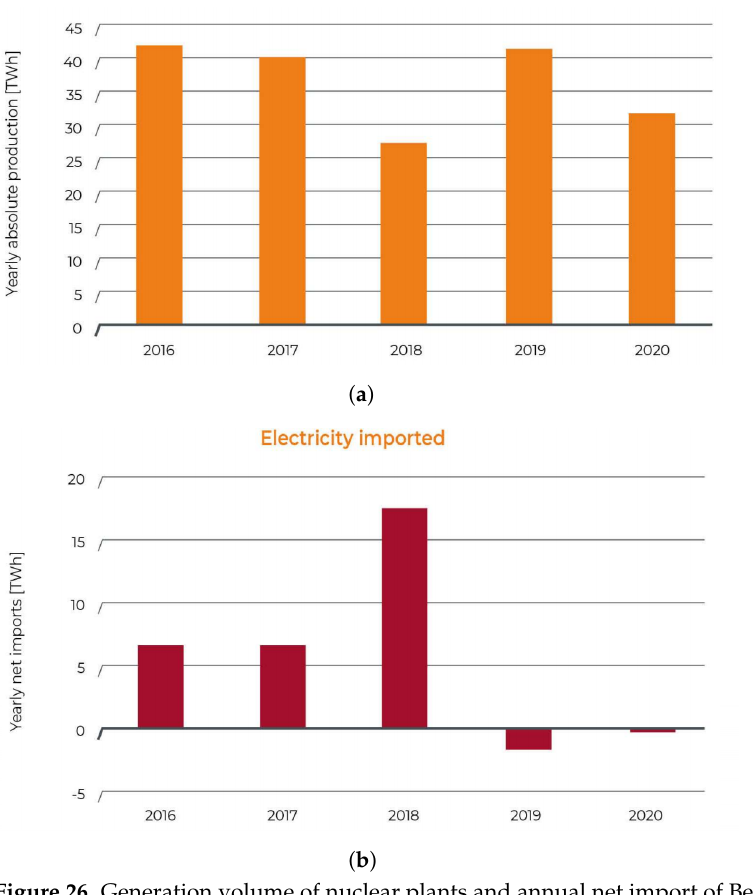
Figure 26. Generation volume of nuclear plants and annual net import of Belgium [157]: ( a ) Yearly absolute production. ( b ) Yearly net imports.